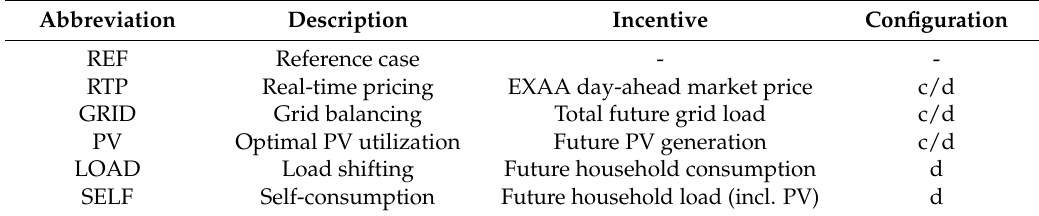
Table 1. Incentives used to drive battery energy storage system (BESS) optimization. The considered configurations for BESS are abbreviated by c for a single, central storage and d for multiple, distributed